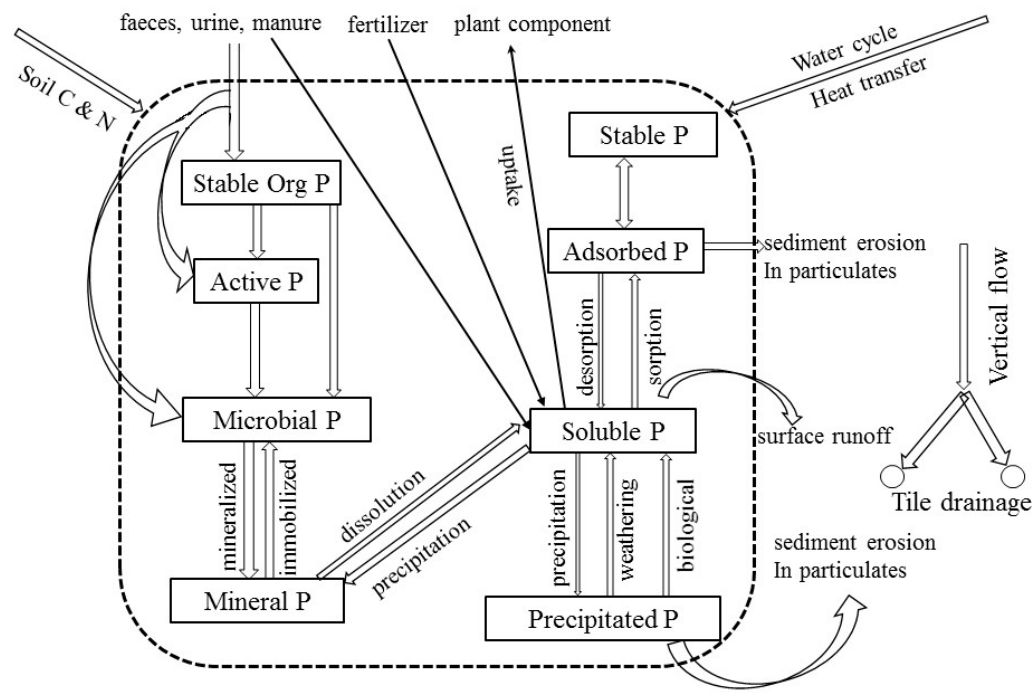
Figure 5. Phosphorus pools (named within the solid rectangle) and their interactions in the P-cycle used in the P module. The arrows between two pools are P flows with specific processes (named next to the arrows) or partitioning (without explanation next to the arrows). The arrows outside the dotted rectangular indicated either the interactions with soil carbon and nitrogen or the influences of soil water redistribution and heat transfer.